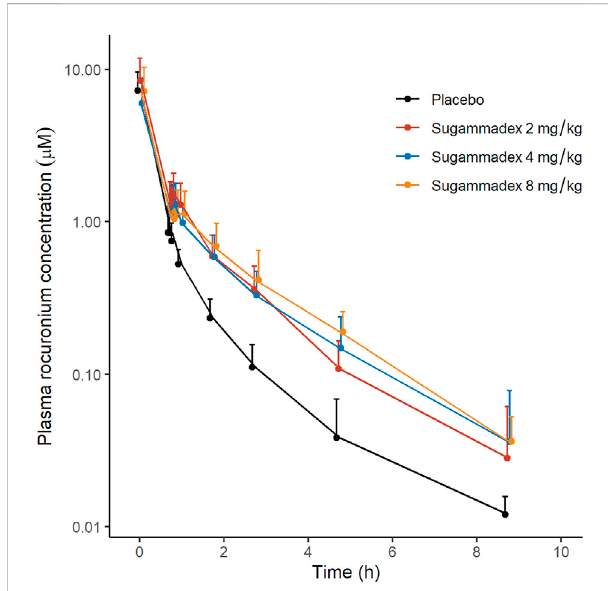
FIGURE 5 Plasma concentrations of rocuronium as a function of elapsed time after rocuronium administration, discriminated by allocated group.The y -axisislogarithmicallyscaled,andtheerrorbarsrepresent standard